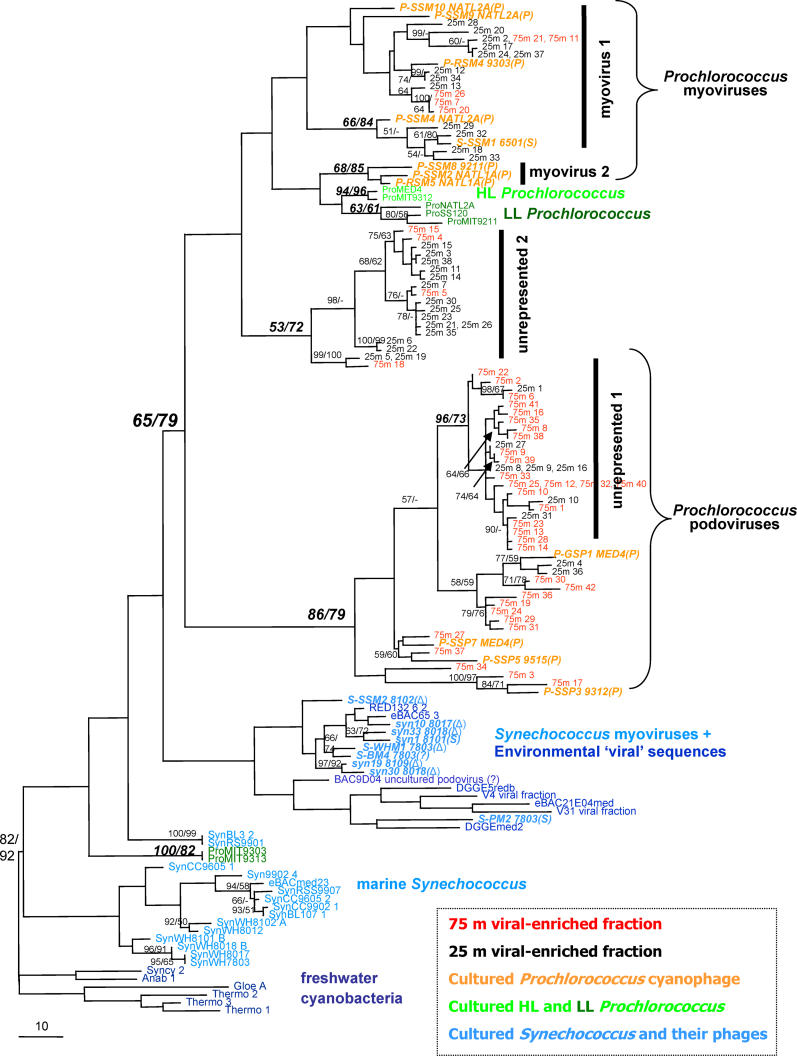
Phylogenetic Tree of
psbA Gene Sequences from Representative Cultured Cyanobacterial and Cyanophage Isolates and Cloned Environmental Sequences from the Hawaii Ocean Time Series Site in the Pacific Ocean
Phylogenetic tree of
psbA gene sequences and cloned environmental sequences were collected from above (25 m, black) and below (75 m, red) the surface mixed layer at the Hawaii Ocean Time Series site in the Pacific Ocean, a region where
Prochlorococcus are the dominant phototrophs. Details for naming conventions are as in
Figure 1.
Synechococcus environmental “viral” sequences from [
37]. The tree topology was estimated by LogDet analysis of 1st and 2nd codon positions, with branch lengths estimated using stationary nucleotide frequencies.